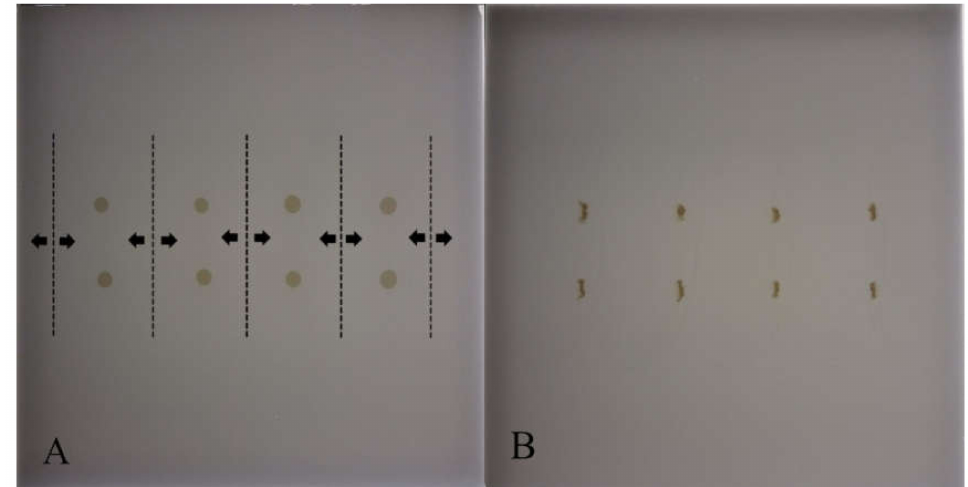
Figure 2. Chromatographic plate with ( A ) starting spots of the samples before their narrowing, and ( B ) starting spots of the samples after their narrowing. The dashed lines mark the path of the pipette delivering the eluent, the arrows indicate the directions of the eluent migration. Stationary phase: HPTLC Silica gel. Plates’ images were captured under white light illumination. Samples: extract from premixture with monensin.